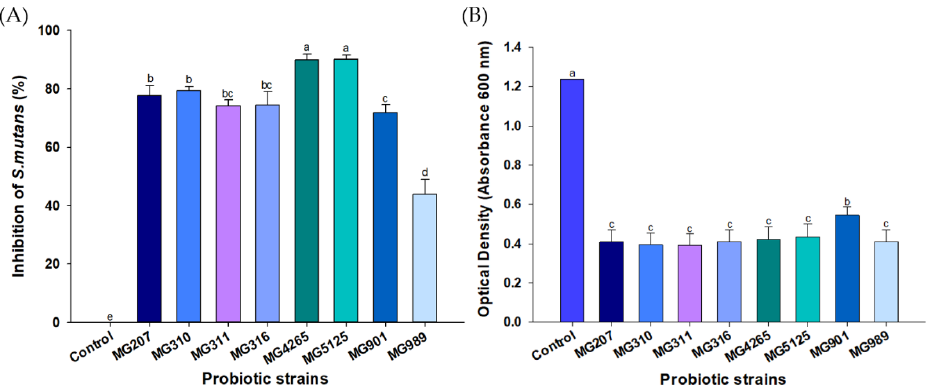
Figure 1. Effect of ( A ) probiotic strains and ( B ) their spent culture supernatants (SCSs) on the growth of S. mutans . Different letters (a–e) indicate significant difference at p < 0.05.